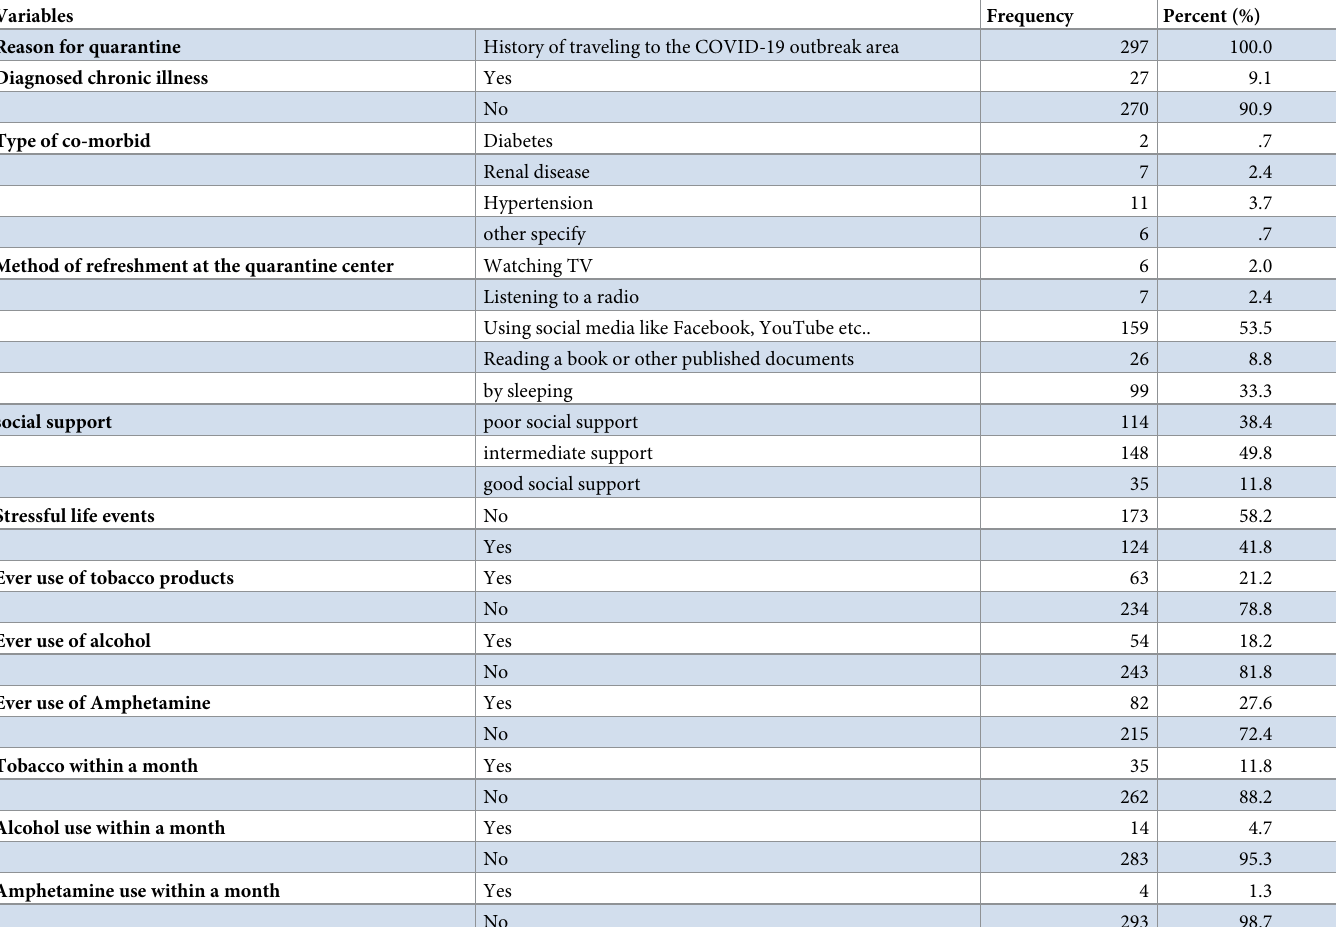
Table 2. Description of clinical, psychosocial & substance use factors among individuals under Quarantine for the case Covid-19 Pandemic, at Addis Ababa, Ethio- pia,